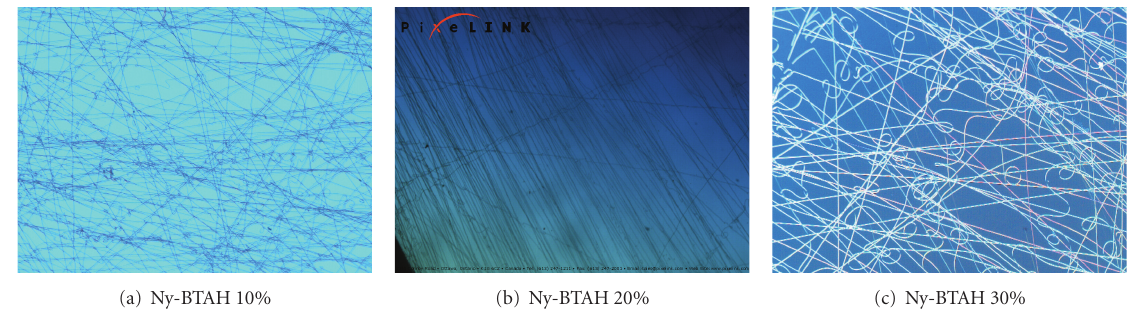
Figure 4: Optical microscope micrographs of electrospun Ny-BTAH at 12kV, 0.2 mL/h, and 12cm, at 10X magnification, for di ff erent